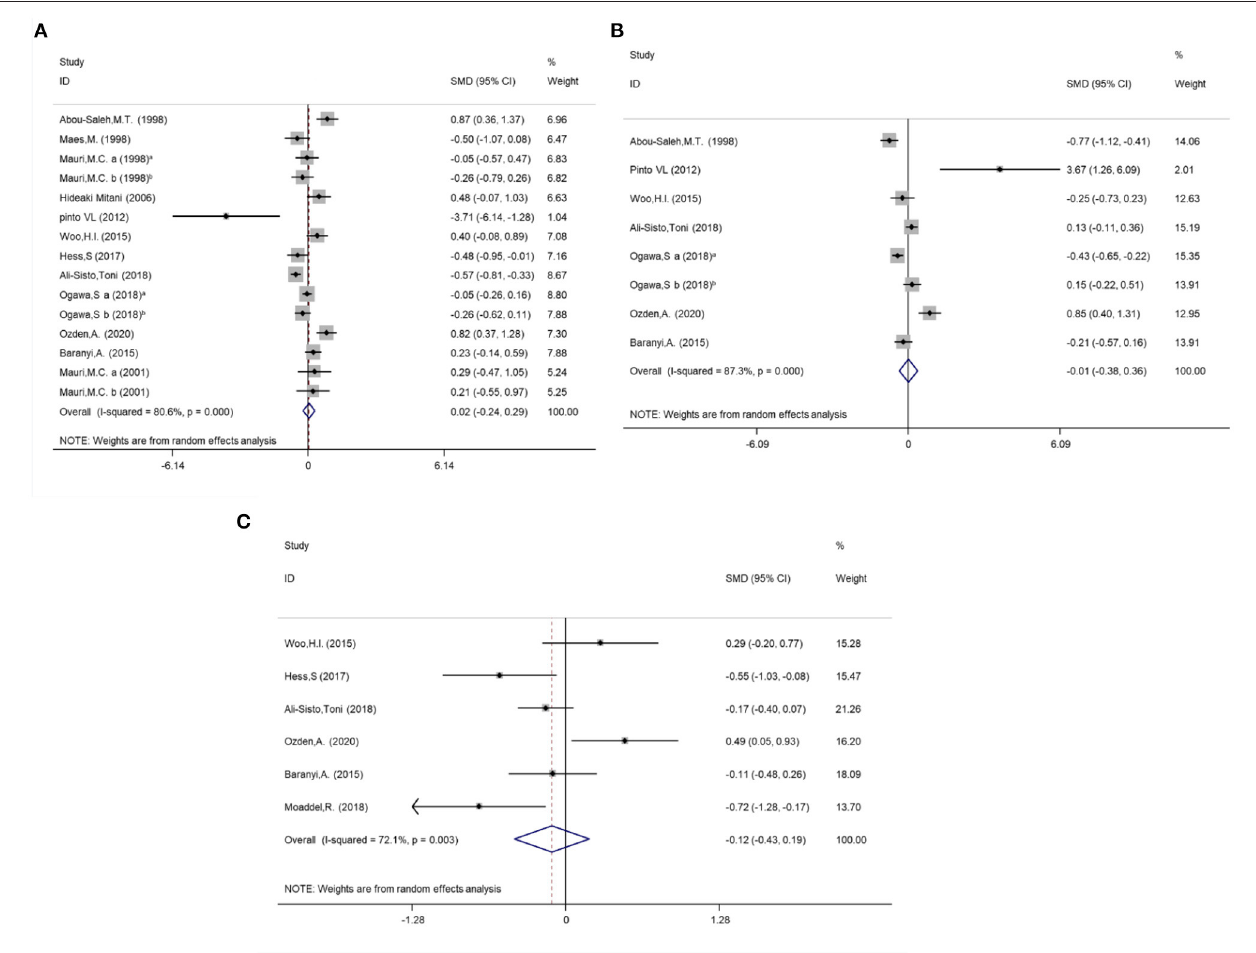
FIGURE 2 | Meta-analysis for the difference of the Arginine, Ornithine and Citrulline concentrations between MDD individuals and controls by random effect analysis. (A) Arginine; (B) Ornithine. (C) Citrulline. Mauri et al. (54) a: sample type was plasma; Mauri et al., (54) b: sample type was platelet; Mauri et al., (55) a: sample